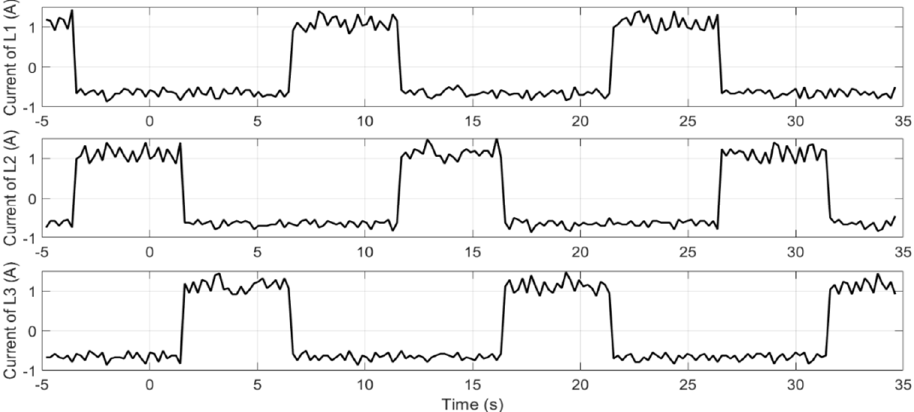
Figure 9. Experimental results: Waveforms of the conductor currents.